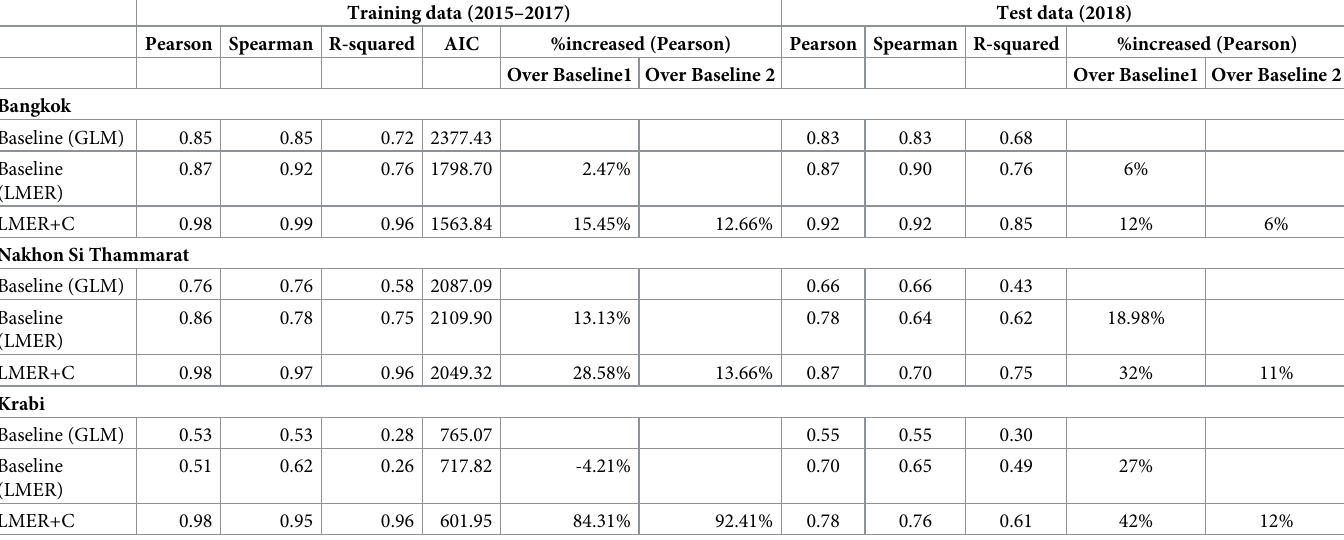
Next, we use the models fitted earlier with three years of training data (2015–2017) and per- form prediction on one year of test data (2018). The results are shown in the right half of Table 4. In Bangkok, the Pearson correlation of the LMER+C model is 12% higher than that of Table 4. Performance of the models on training data (2015–2017) and test data (2018). Training data